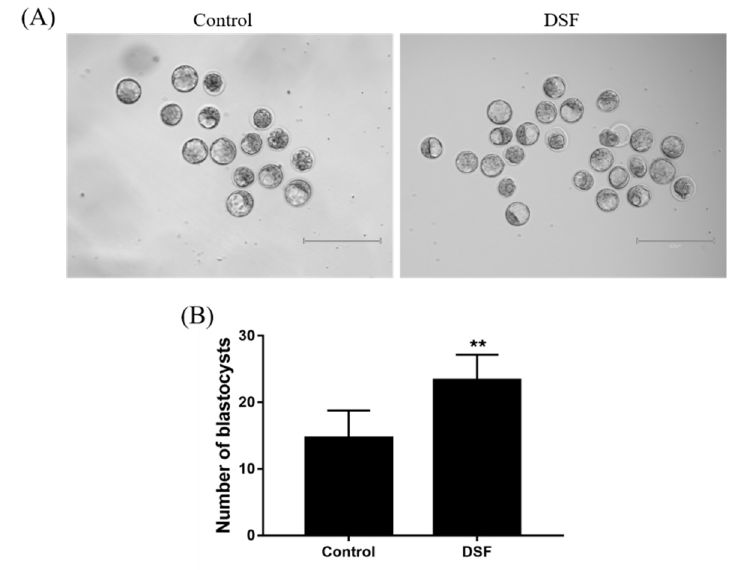
Figure 8. Effect of DSF on the number of blastocysts in mice. ( A ) Representative images of the number of blastocysts per mouse in the Control and DSF groups; ( B ) Comparison of the number of blastocysts per mouse in the Control and DSF groups; ** p < 0.01; scale bar = 400 µ m. Control group, n = 6; 50 mg/kg DSF group, n = 6.